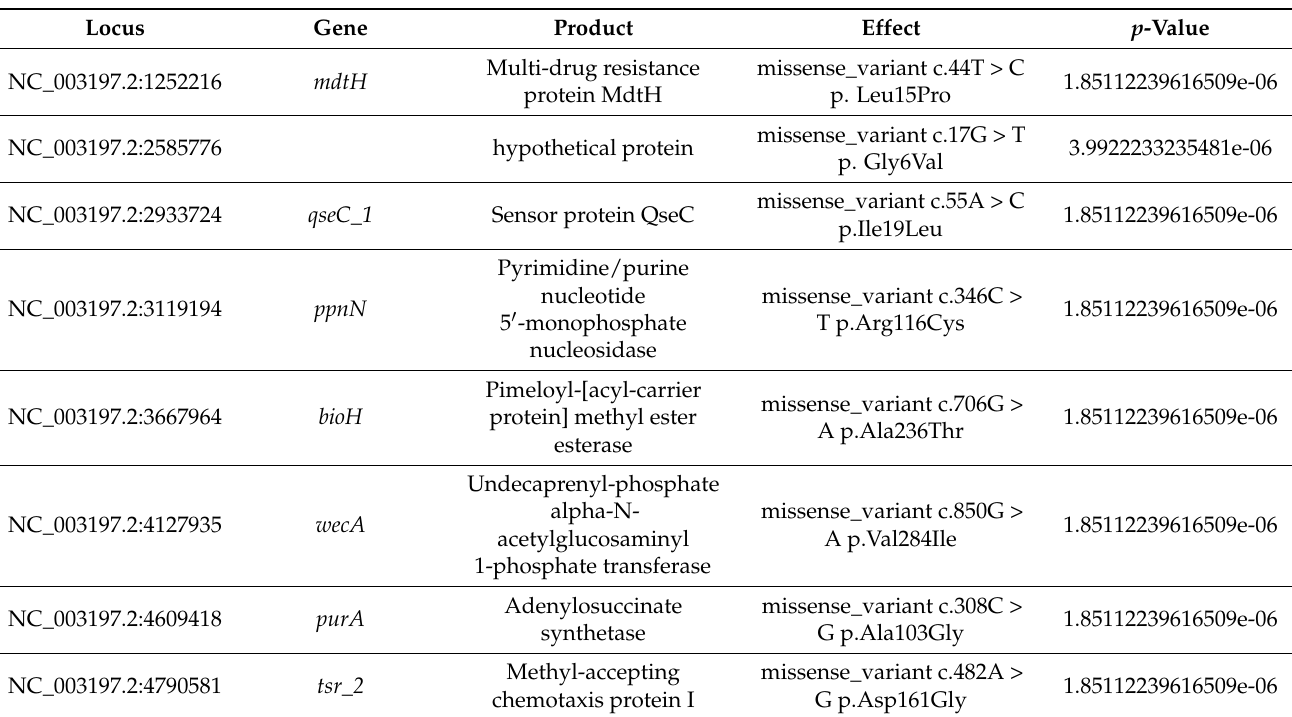
Table 3. Potential nitrofurantoin resistance eight genes and their SNVs identified with